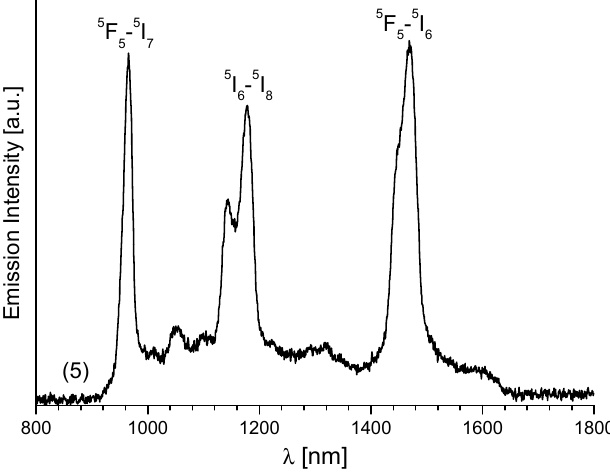
Figure 8. The emission spectrum of 5 (Ho) in NIR region.